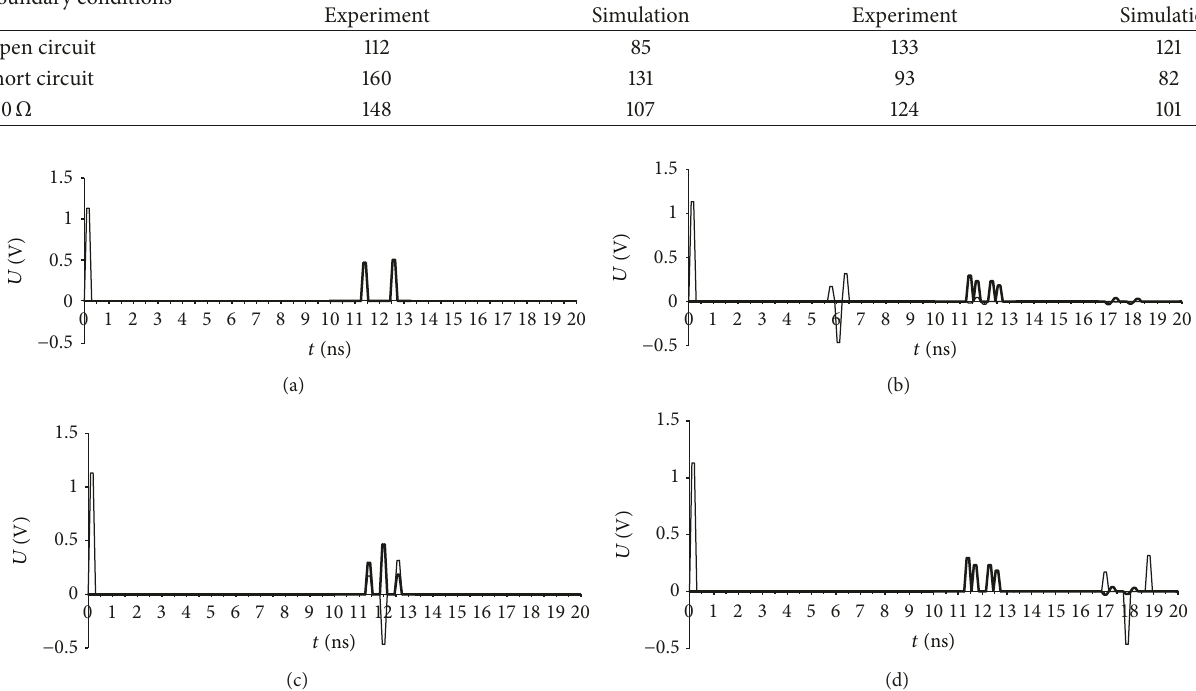
Figure 11: Simulated waveforms at the near (—) and far ( — ) ends of the probing line without the break of the passive wire (a) and with its break at distances of 0.5 (b), 1 (c), and 1.5 (d) m from the beginning.